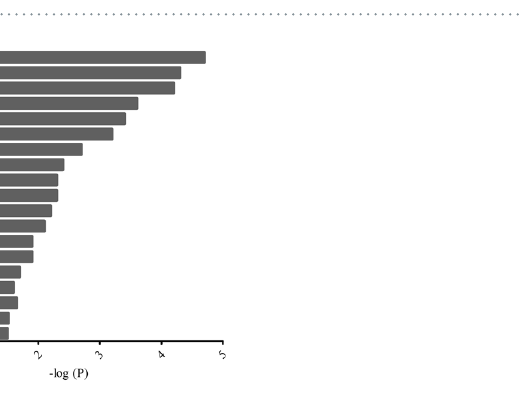
Figure 3. List of statistically enriched pathways of miRNAs target. Bar-chart showing the statistically enriched pathways (P ≤ 0.05, Fisher’s test) where the mRNAs target of miRNAs are involved. Pathways analysis was performed using “Core Analysis” function of Ingenuity Pathway Analysis